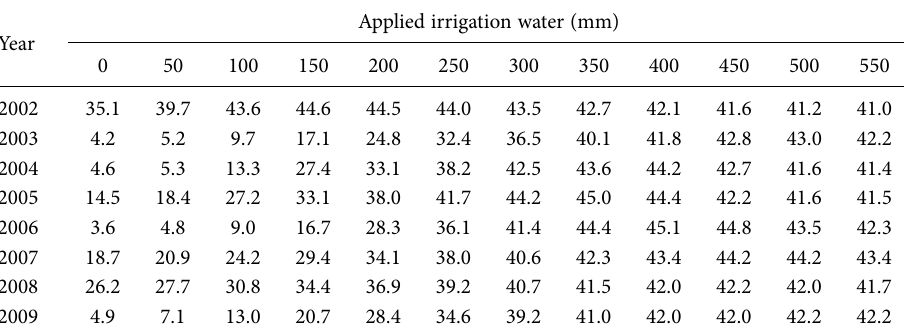
Tomato Table 3. Production level according to different AIW - Sugarbeet (t/ha).